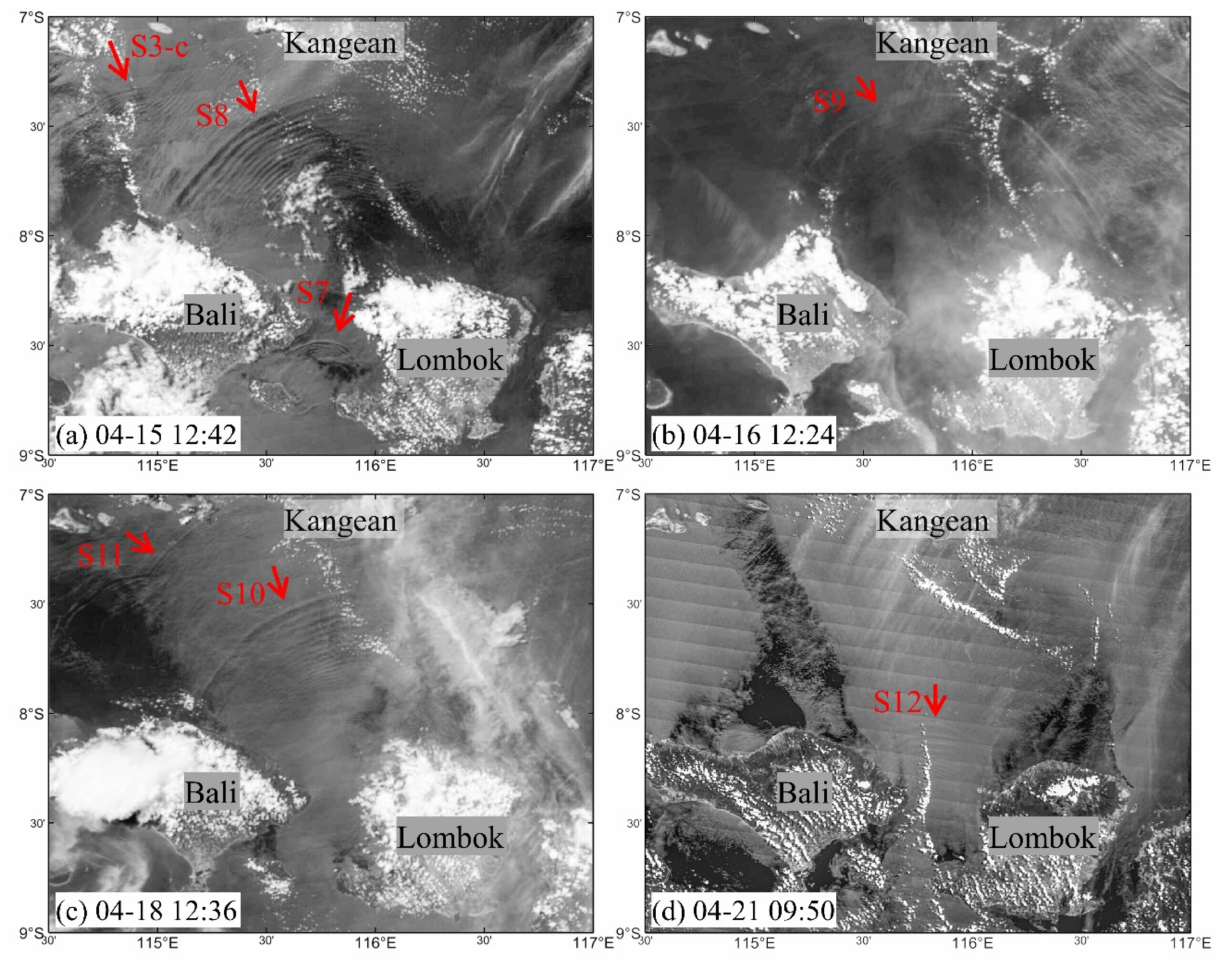
Figure 2. Optical remote sensing images over the BS acquired on 15, 16, 18 and 21 April 2021 (local time) by VIIRS ( a – c ) and by MODIS ( d